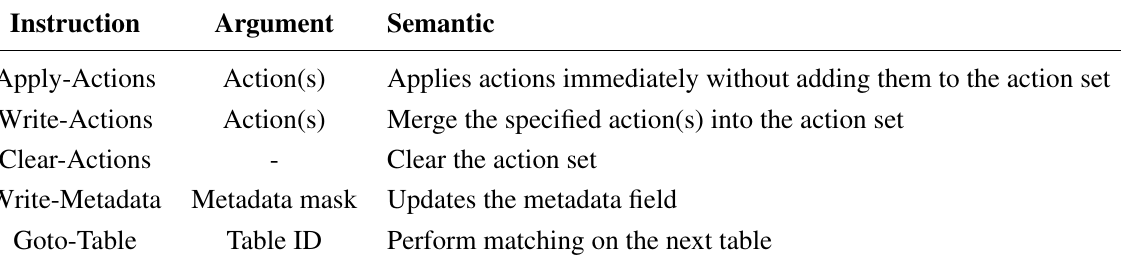
Table 1. List of instructions for OpenFlow